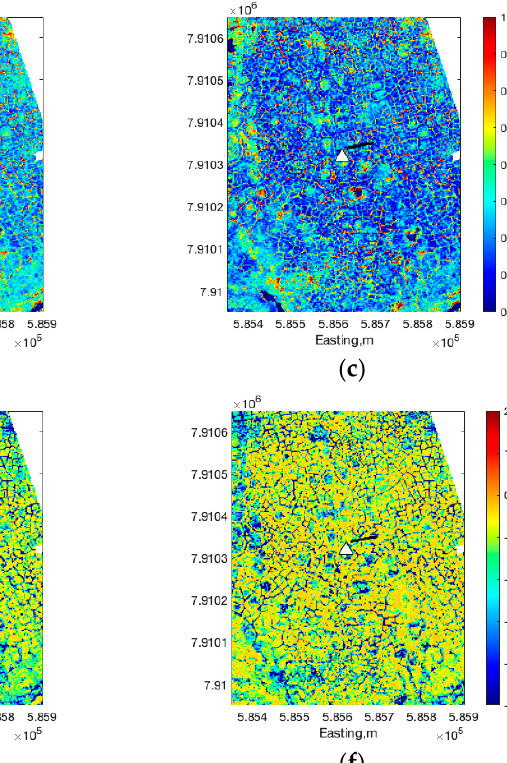
Figure 7. Changes of NDVI over the site in 2014 on ( a ) DOY 185, ( b ) DOY 210 and ( c ) DOY 240, and the changes of NEEday (in μ mol/m 2 /s) over the site on ( d ) DOY 185, ( e ) DOY 210 and ( f ) DOY 240. In each plot, the black line represents the tram location, and the white triangle is the flux tower location.